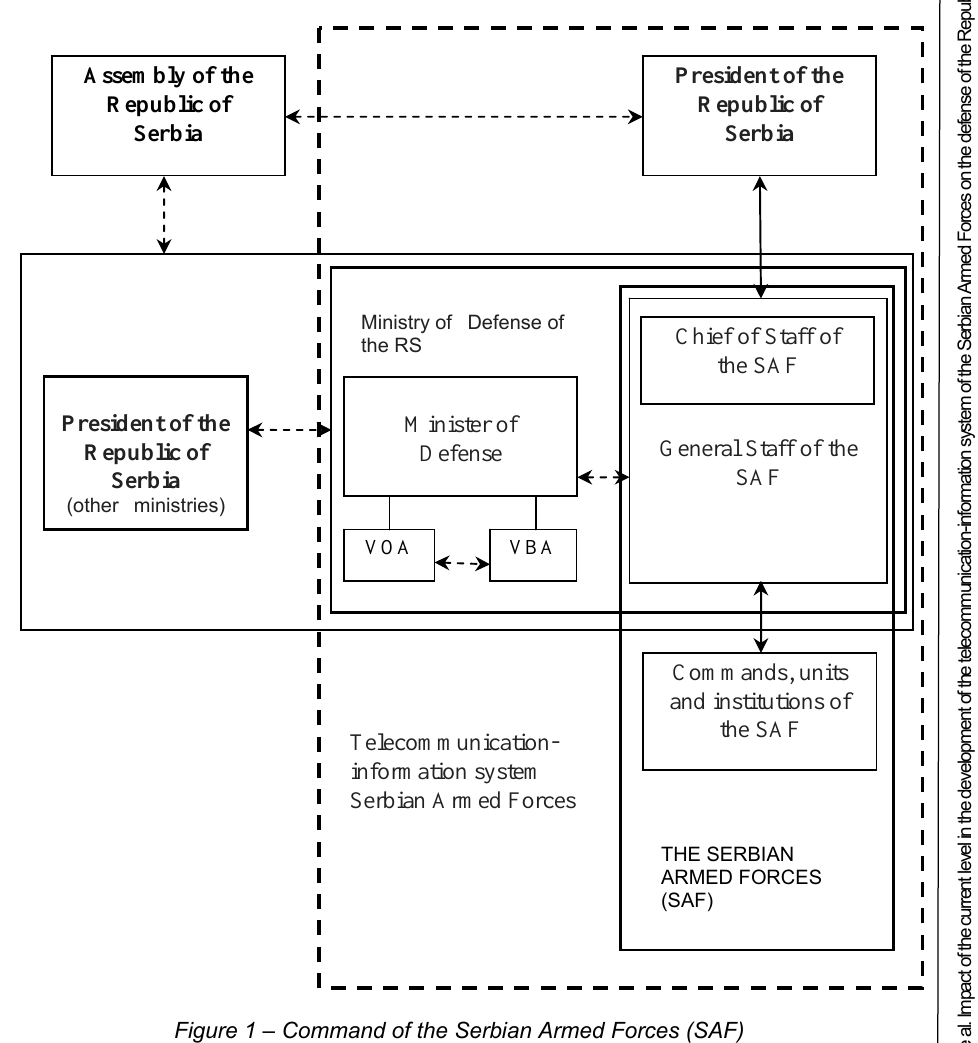
Figure 1 – Command of the Serbian Armed Forces (SAF) Рис . 1 – Командование Вооруженными силами Республики Сербия Слика 1 – Командовање Војском